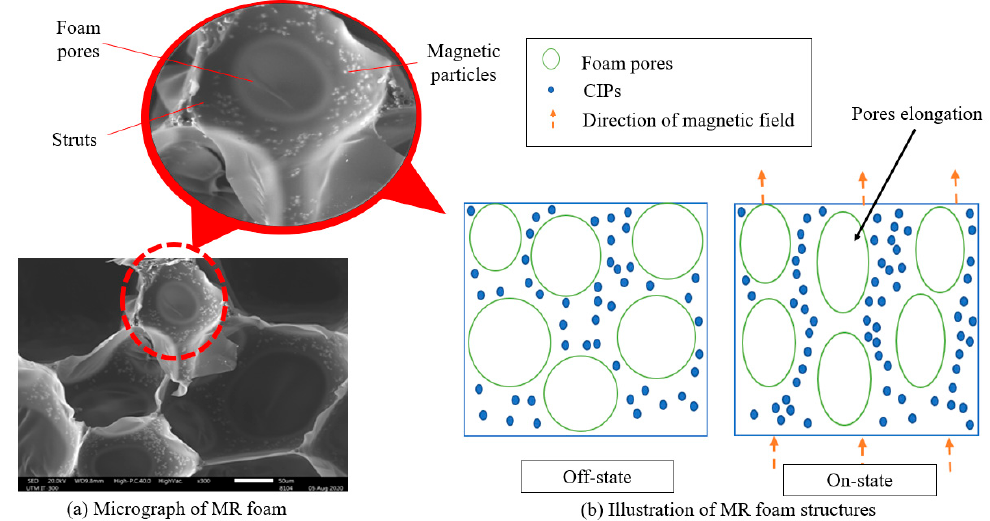
Figure 10. ( a ) Variable Pressure Scanning Electron Micrograph (VP-SEM) of MR foam. ( b ) Schematic illustration of MR foam during on-state conditions.